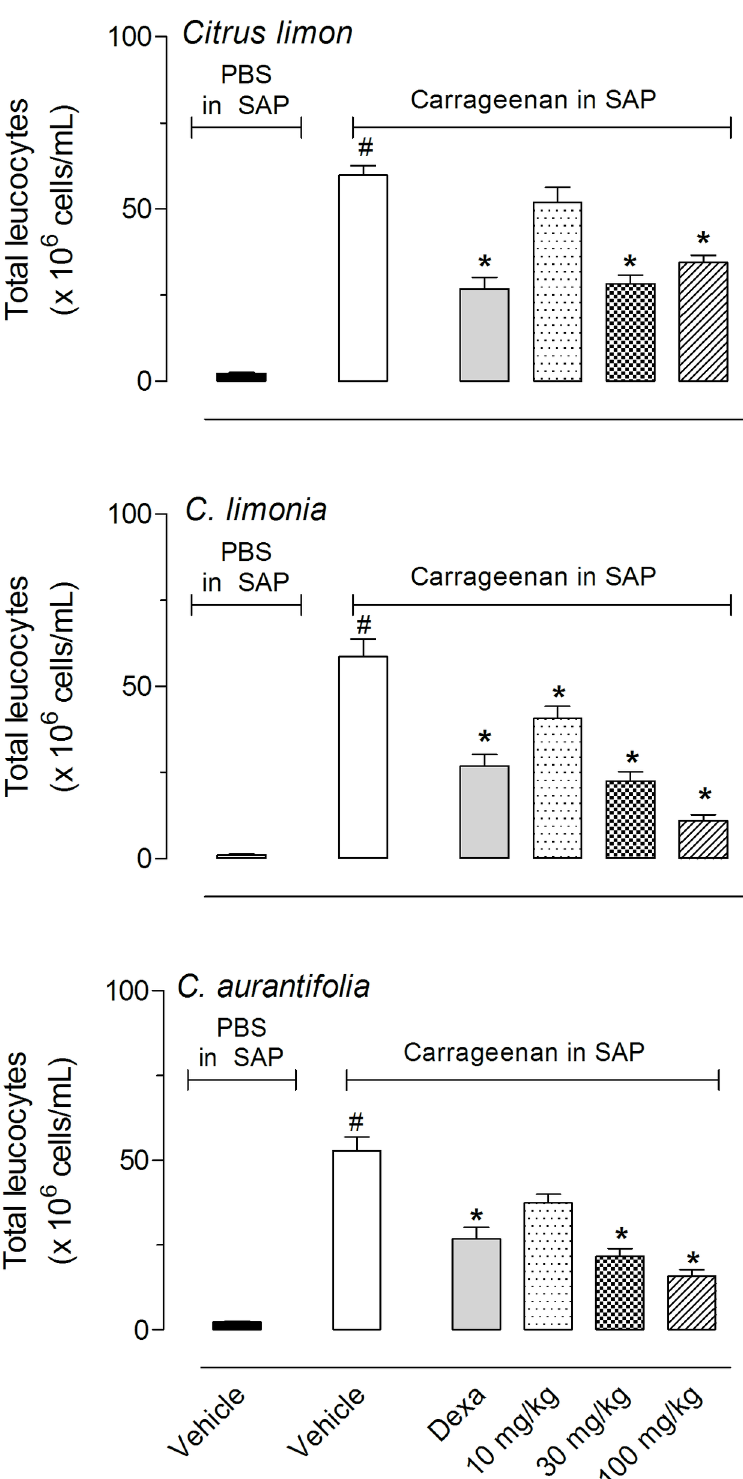
Fig 3. Effects of C . limon , C . limonia and C . aurantifolia essential oils on leukocyte migration into the subcutaneous air pouch (SAP). Animals were pretreated with different doses of the essential oils, dexamethasone (Dexa, 5 mg/kg, i.p.) or vehicle 1 h prior to carrageenan (1%) injection into the SAP. The results are presented as the mean ± S.D. (n = 10 per group) of cells (x 10 6 /mL) in the SAP.